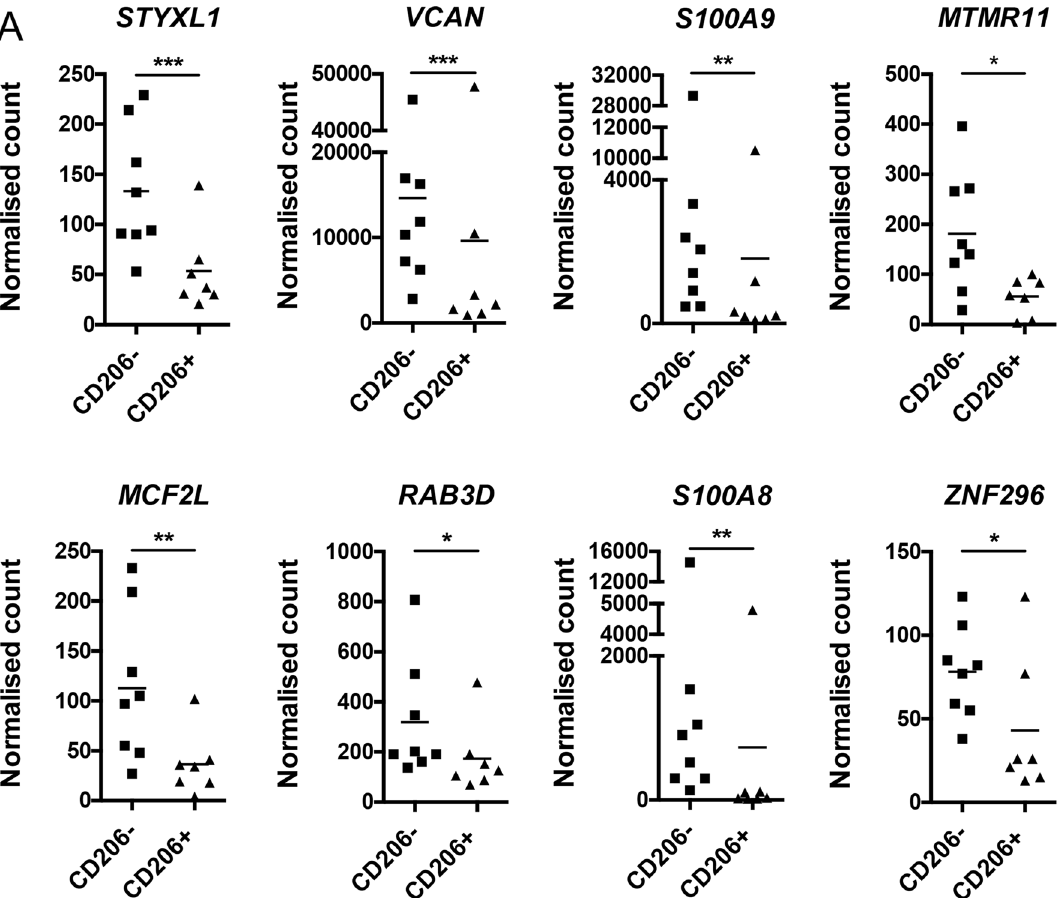
Figure 4. RNAseq analysis of FACS-purified CD206 − and CD206 + colonic human macrophage populations from healthy individuals. ( A ) Expression of differentially expressed genes between macrophage populations (CD206 − and CD206 +). Intestinal macrophages derived from normal colon resections; n = 8 and 7 for CD206 − and CD206 + , respectively.